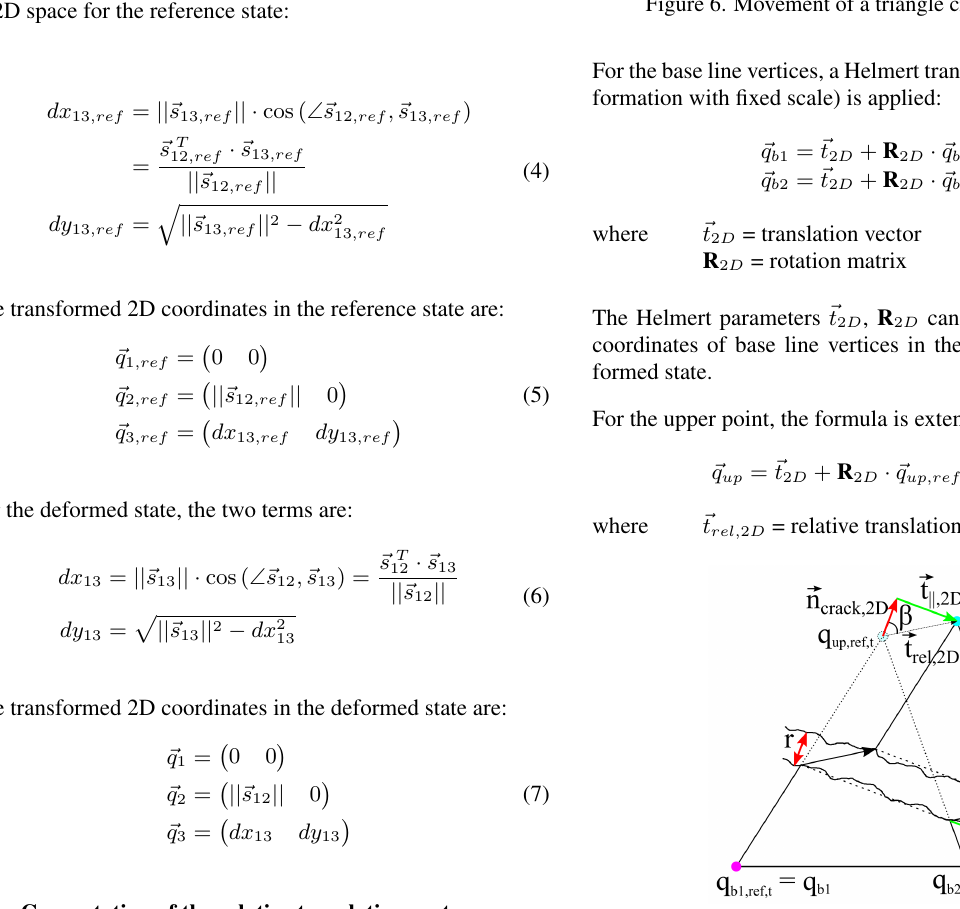
Figure 7. Deformed and transformed reference triangle. r : crack width. q j,ref,t : transformed reference points with index j. The relative translation vector can be computed by reorganizing